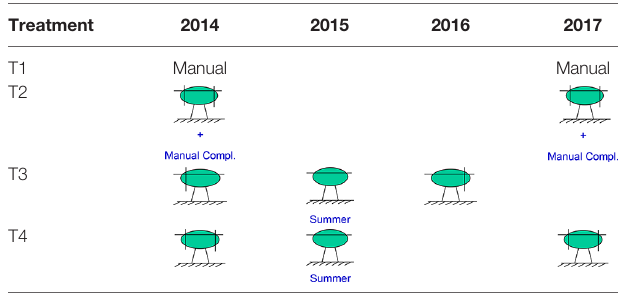
TABLE 2 | Treatments: pruning interventions sequence.